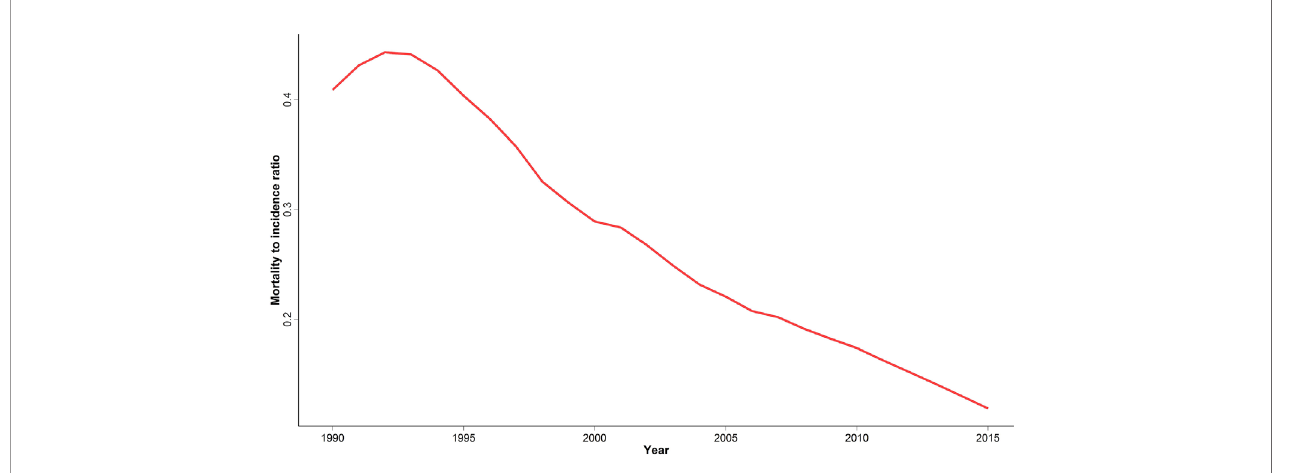
FIGURE 5 | National time trend of mortality to incidence ratio; 1990 to